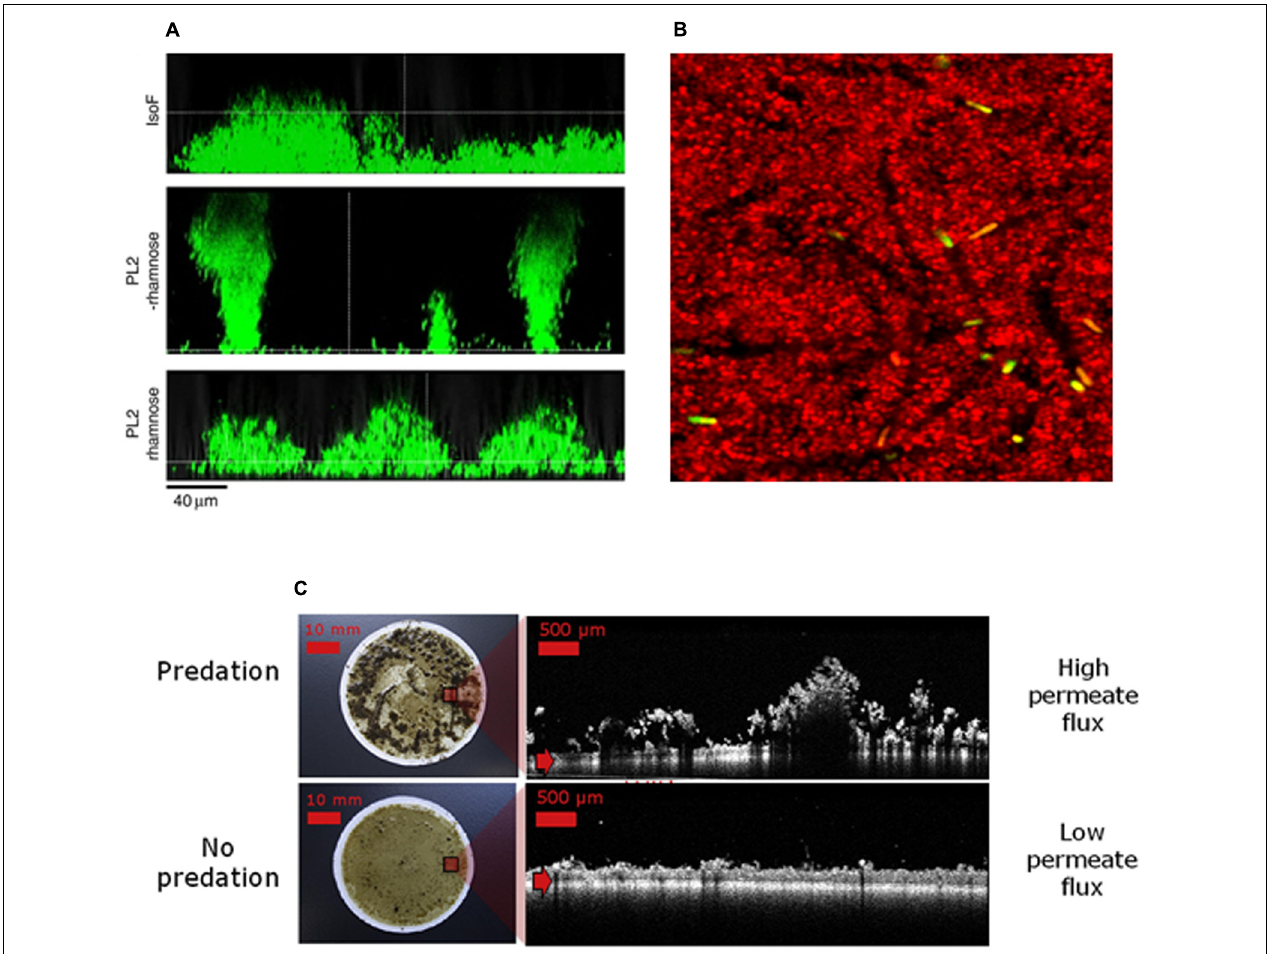
FIGURE 3 | Sculpting biofilm architecture to control their function. (A) Role of biosurfactants in Pseudomonas putida biofilm architecture. Images displayed vertical sections of biofilms grew in flow chamber during 3 days in presence or absence of rhamnoses. IsoF correspond to the wild-type strain and PL2 strain to a conditional mutant in which the native promoter region of psoA (a gene coding a large non-ribosomal peptide synthethase which directs the biosynthesis of the two cyclic lipopeptide biosurfactants putisolvin I and II) has been replaced with the rhamnose-inducible PrhaB promoter (adapted from Carcamo-Oyarce et al., 2015). Addition of 0.2% rhamnose in growth medium of PL2 lead to the recovery of the flat wild-type biofilm structure suggesting that putisolvins promote the colonization of the substratum. (B) Predation by protozoa affects biofilms spatial organization during gravity-driven dead-end ultrafiltration and induces higher permeate fluxes (adapted from Derlon et al., 2012). (C) Green bacilli creates transient pores in the biofilm matrix of Staphylococcus aureus , leading to an increased sensitivity to biocide action as described in Houry et al. (2012) (courtesy of Julien Deschamps,